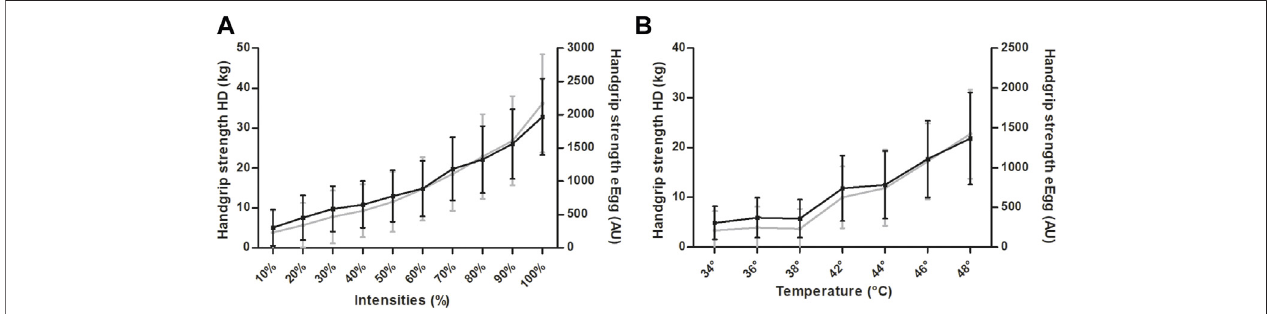
FIGURE4| MeancomparisonofthehandgripstrengthvaluesoftheeEggandthehanddynamometer(HD). (A) Inresponsetointensitiesrangingfrom10to100% of the maximum handgrip strength. (B) In response to thermal stimuli ranging from 34 to 48 ° C. Data are presented as mean ± standard deviation. Grey colour indicates hand dynamometer (HD); Black colour indicates eEgg. eEgg, electronic egg.